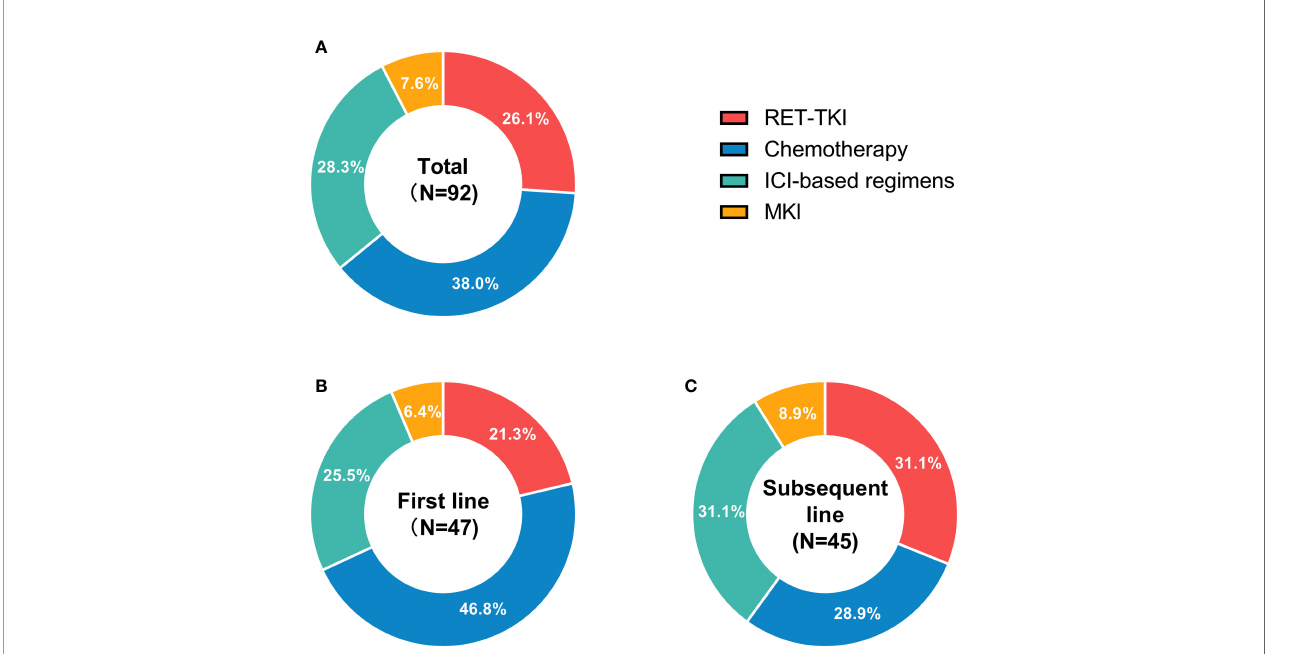
FIGURE 1 | Status of different treatments for RET-fusion non-small cell lung cancer patients in different treatment-lines. (A) The usage status of different treatments in any treatment line. (B) The usage status of different treatments in fi rst-line treatments. (C) The usage status of different treatments in subsequent-line treatments. N, usage count. RET-TKI, rearranged during transfection-tyrosine kinase inhibitors. ICI, immune-checkpoint inhibitor; MKI, multi-kinase